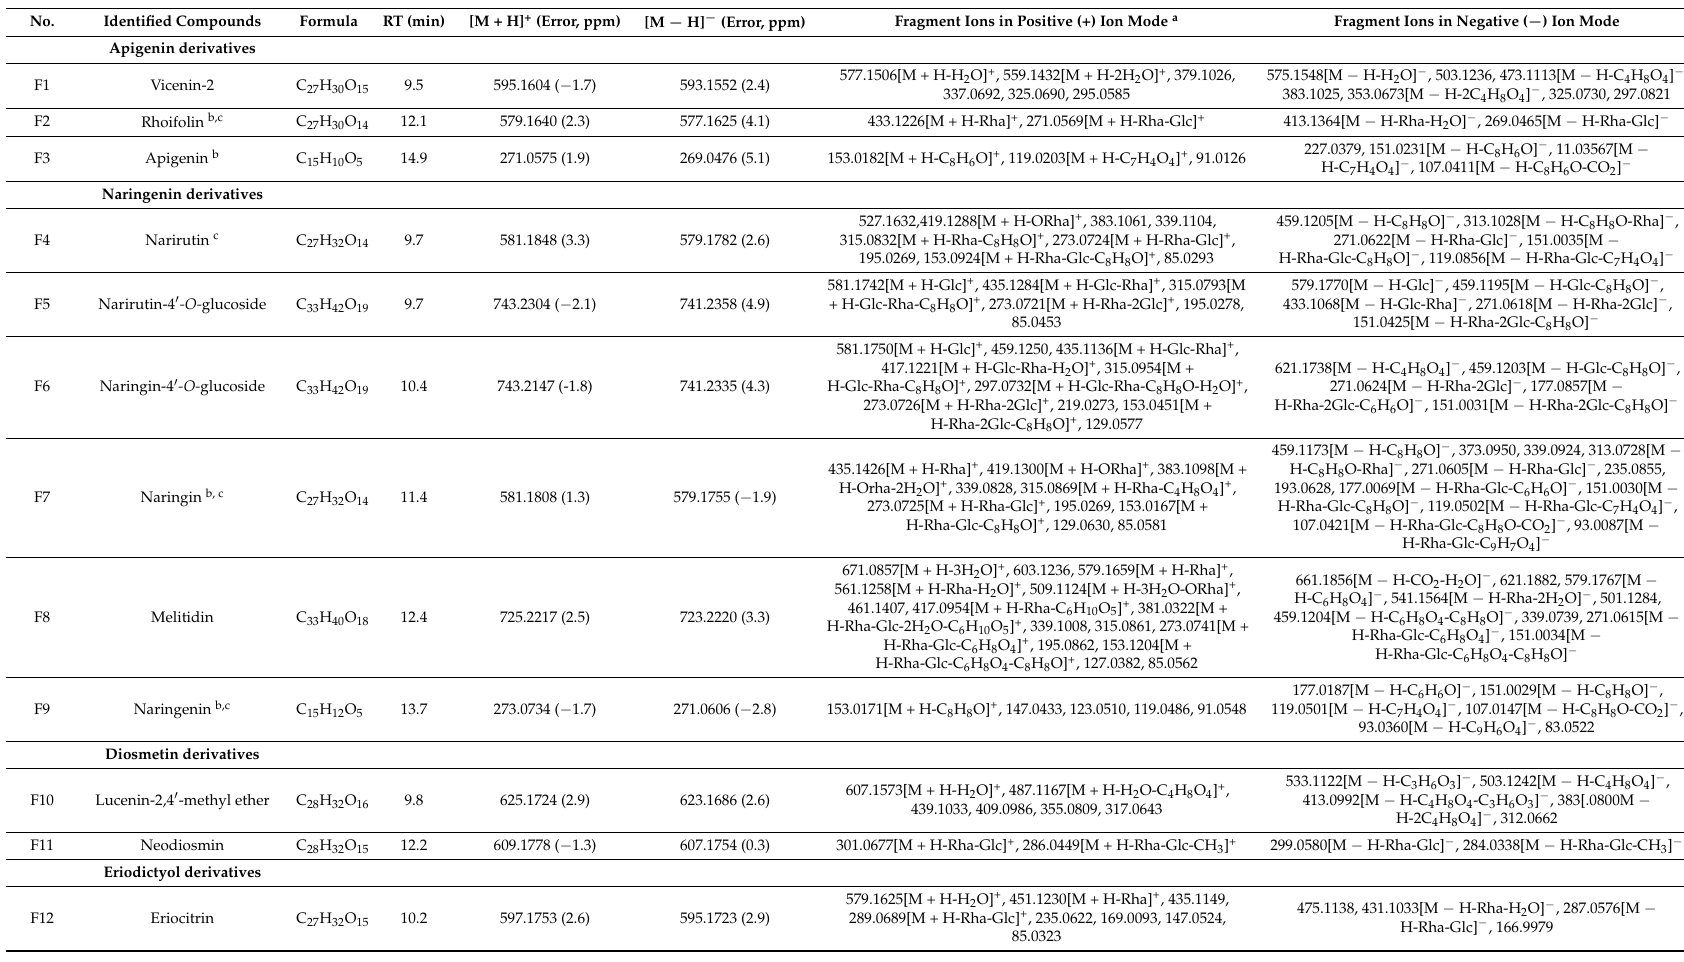
Table 1. Identification of flavonoids in the ECG extract by